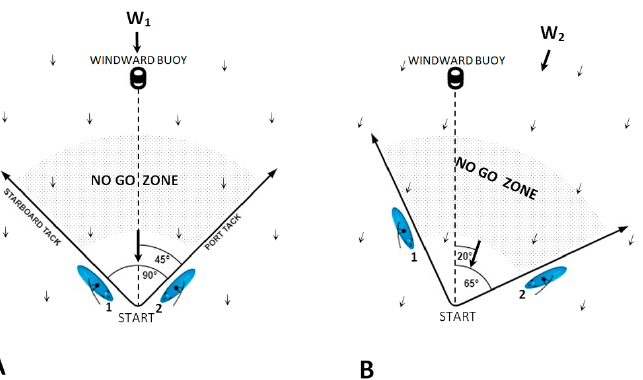
Figure 1. A shift in the optimal courses as a result of change in wind direction. ( A ) the line of wind direction is aligned with the line between the start and windward buoy; ( B ) the line of wind direction is a shift of 20° from the line between the start and windward buoy. W1, W2—direction of the example wind.